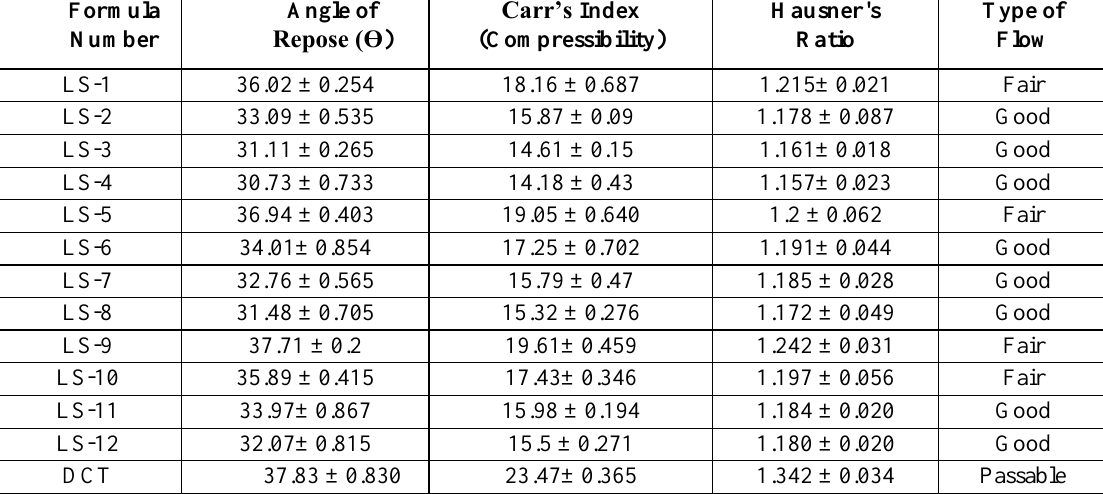
Table 3. Angle of repose, carr’s compressibility index and Hausner’s ratio for clopidogrel liquisolid systems